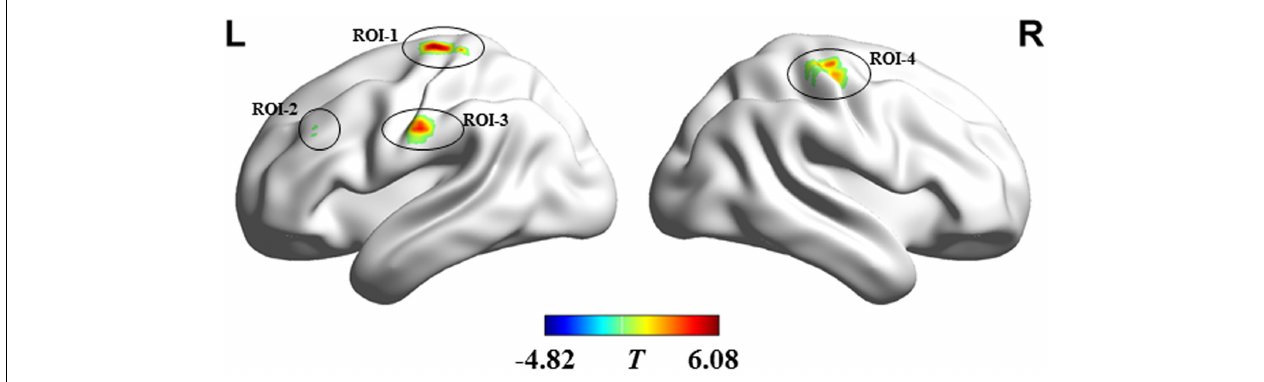
FIGURE 2 | Regions showing between-group differences in dFCD variability. Regions in red and blue, respectively indicate decreased and increased dFCD variability in individuals with amyotrophic lateral sclerosis. ROI-1 and ROI-3 are located in the left precentral and postcentral gyri; ROI-2 is located in the left middle frontal gyrus; and ROI-4 is situated in the right precentral and postcentral gyri. L, left; R, right.